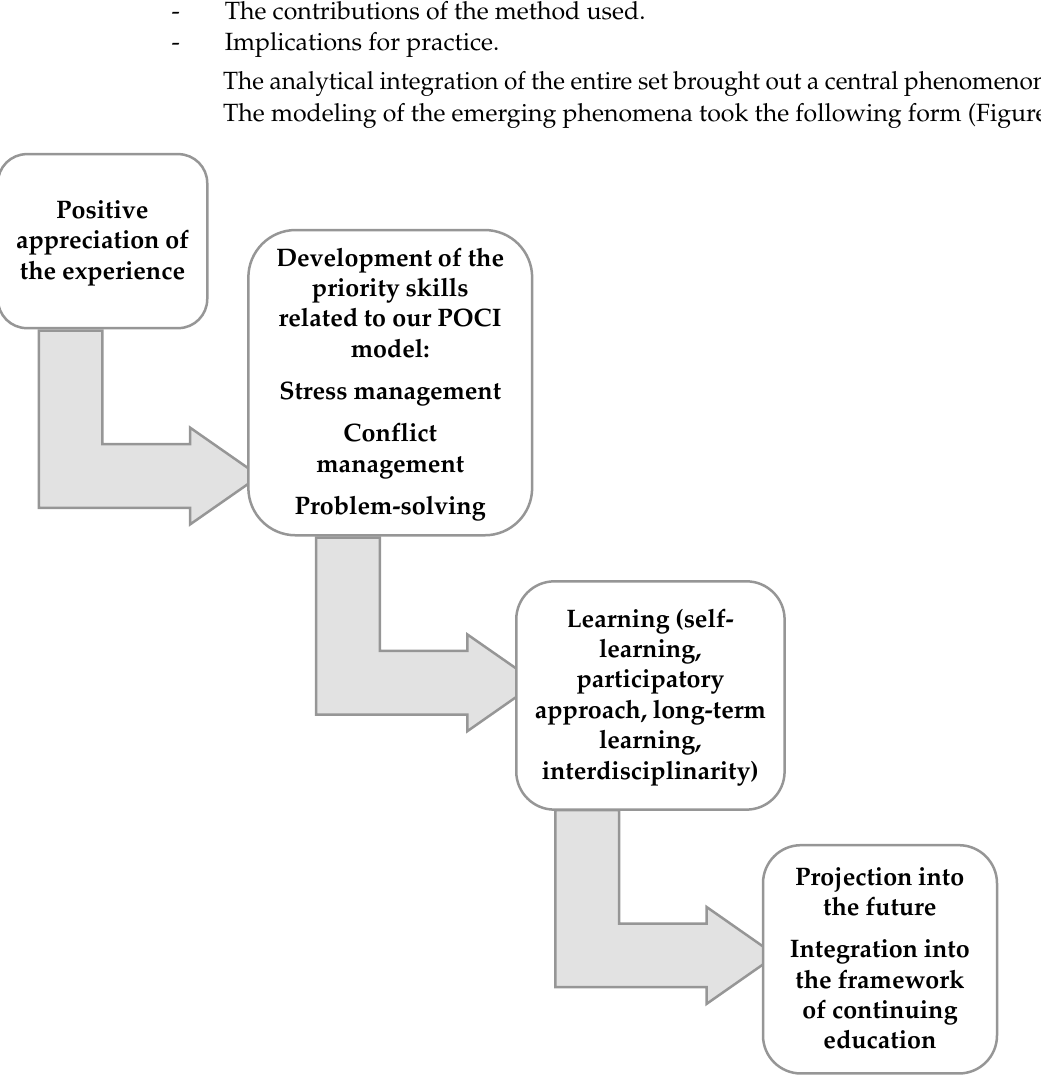
Figure 4. The modeling of the emerging phenomena .